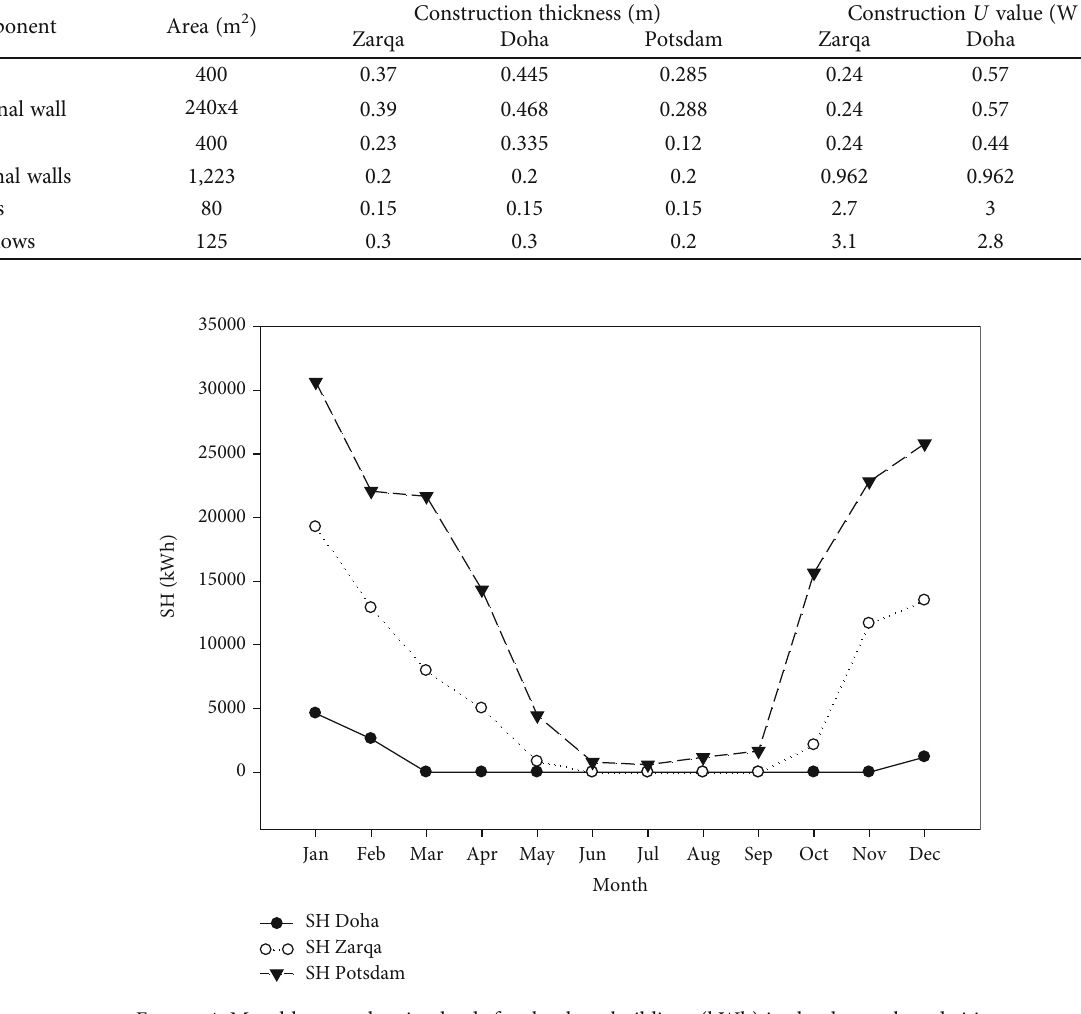
Figure 4: Monthly space heating loads for the three buildings (kWh) in the three selected cities.